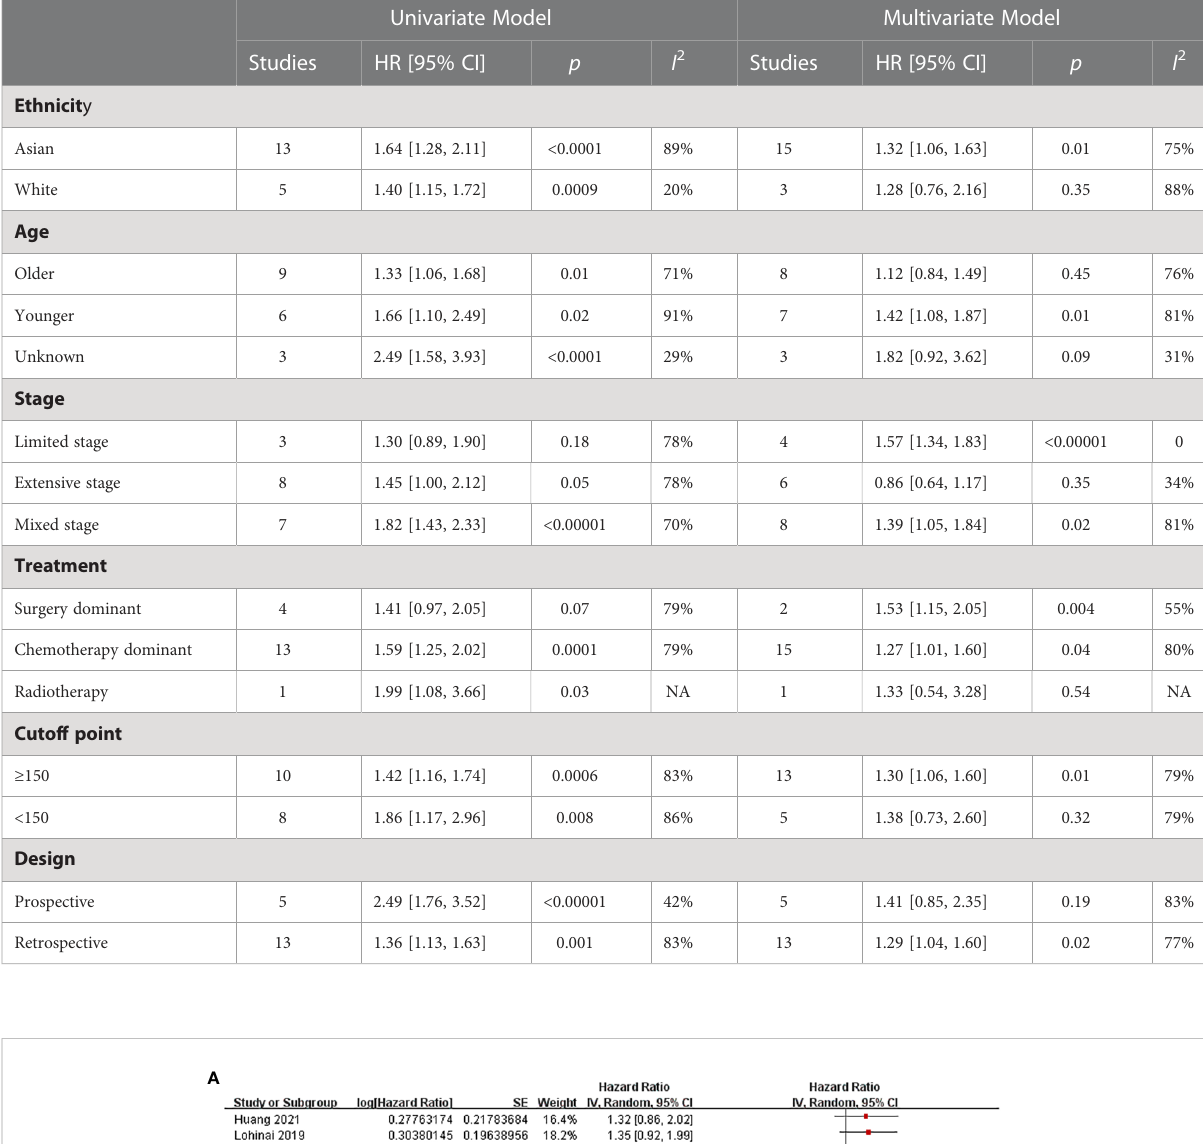
TABLE 2 Subgroup analysis about the effect of PLR level on OS for SCLC patients.